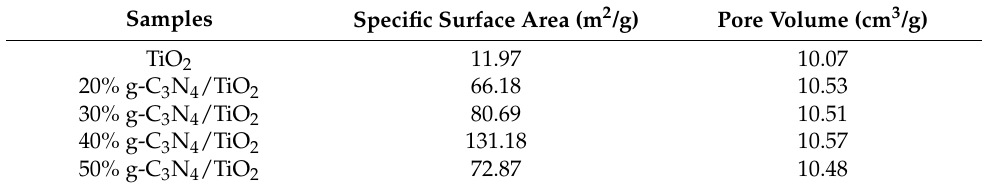
Figure 4. The N 2 adsorption–desorption isothermal curve ( a ); pore diameter distribution curves ( b ). Table 1. The specific surface area of